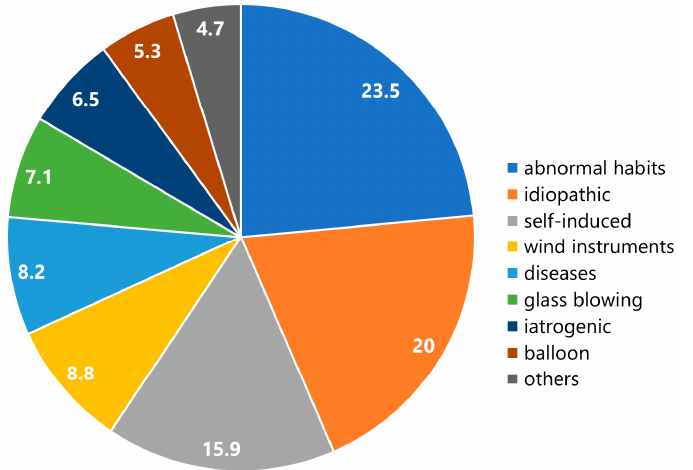
Figure 4. Etiologies of patients with pneumoparotid. The numbers in the pie chart sectors represent percentages.